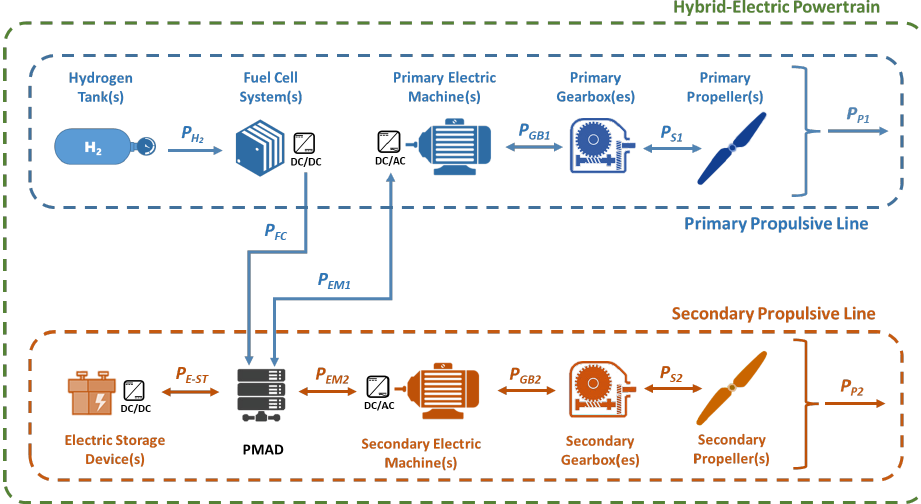
Figure 2. Example of a hybrid-electric propulsive scheme based on hydrogen-based fuel cells and electric storage